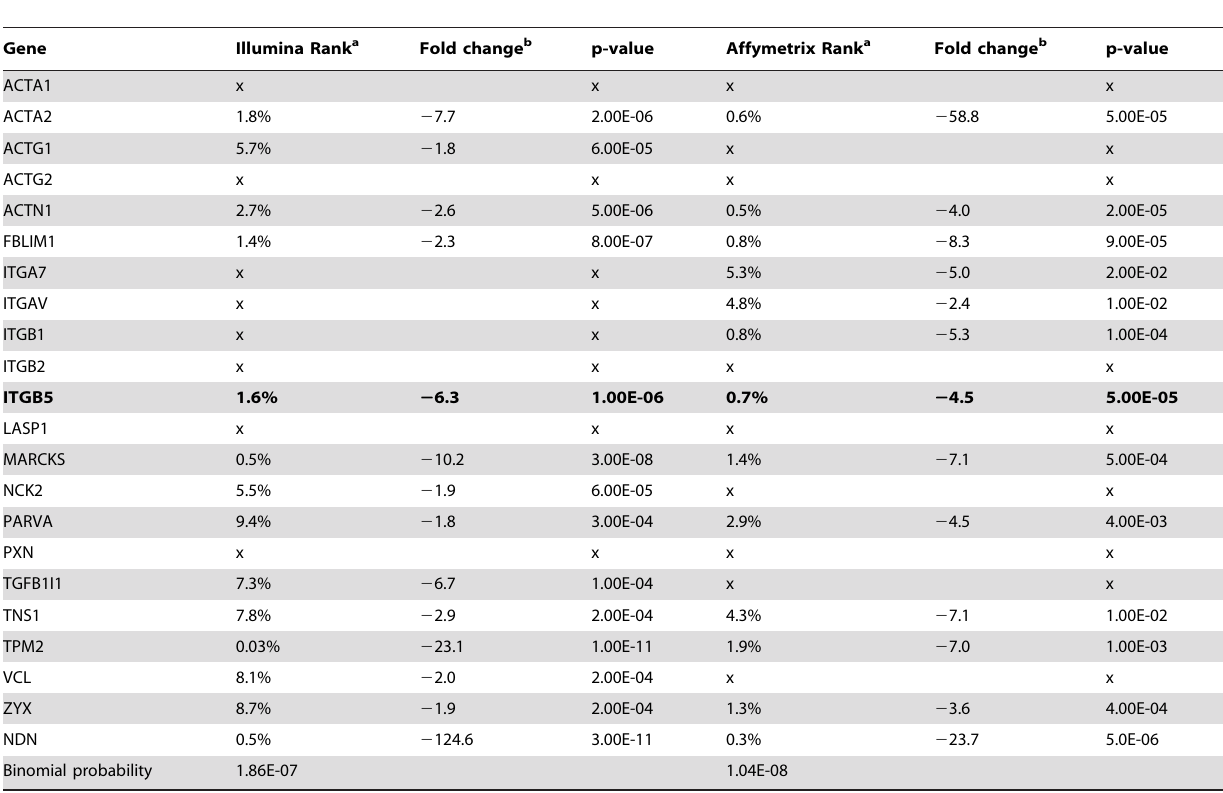
Table 6. Comparison of differentially expressed cytoskeleton and regulatory genes with archived array data sets comparing established human ovarian cell lines with normal ovarian surface